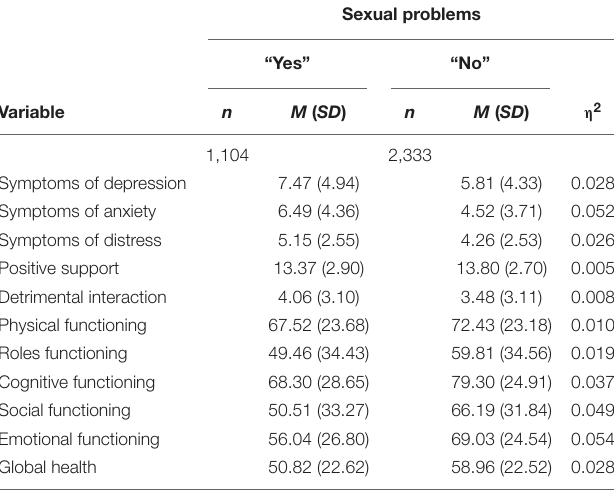
TABLE 2 | Means, standard deviations, and effect